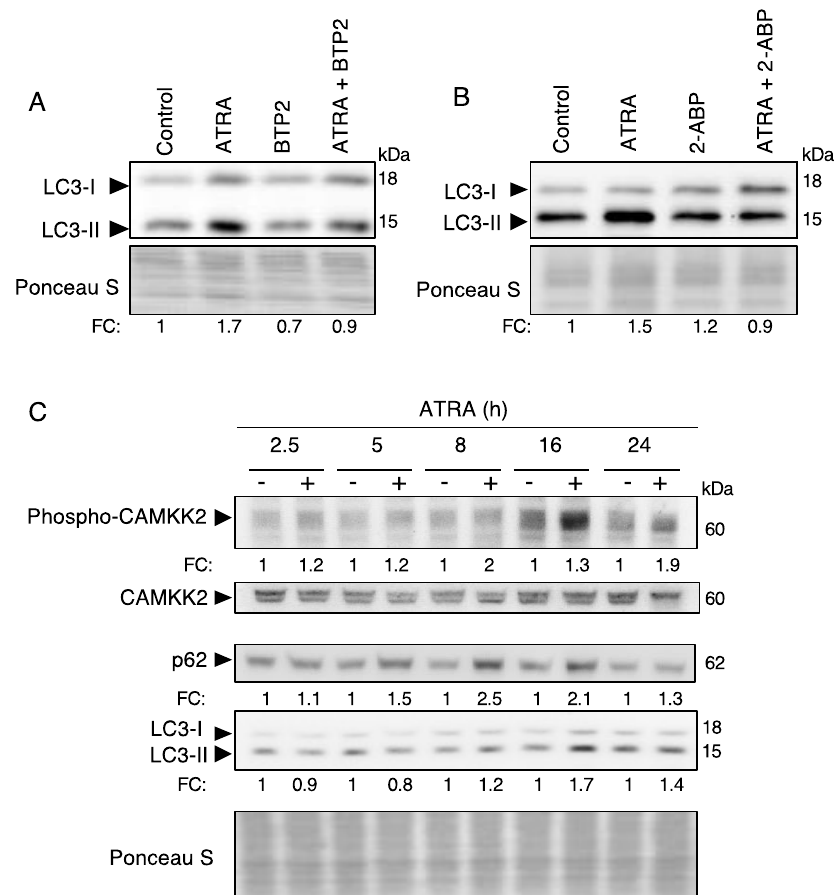
Figure 3. ATRA induces autophagy through a Ca 2+ -dependent mechanism. ( A ) NB4 cells were pre-treated with 5 μM BTP2 for 2 h before treatment with 1 μM ATRA for 24 h. Cell extracts were then analyzed for LC3 levels by western blotting. ( B ) Immunoblot analysis of LC3 levels in NB4 cells pre-treated with 44 μM 2-APB for 2 h and then treated with 1 μM ATRA for 24 h. ( C ) NB4 cells were treated with 1 μM ATRA for the indicated time then subjected to immunoblot analysis for phospho- CAMKK2, CAMKK2, p62 and LC3-II. Ponceau S red staining was used to score the protein loading levels. The expression levels of p62 and LC3-II were scored and normalized to the protein loading levels of each sample. The expression levels of phospho-CAMKK2 and CAMKK2 were quantified and given as ratio of phospho-CAMKK2/CAMKK2. The quantification values represent the ratio of treated cells versus untreated cells (fold change, FC) for each time point.